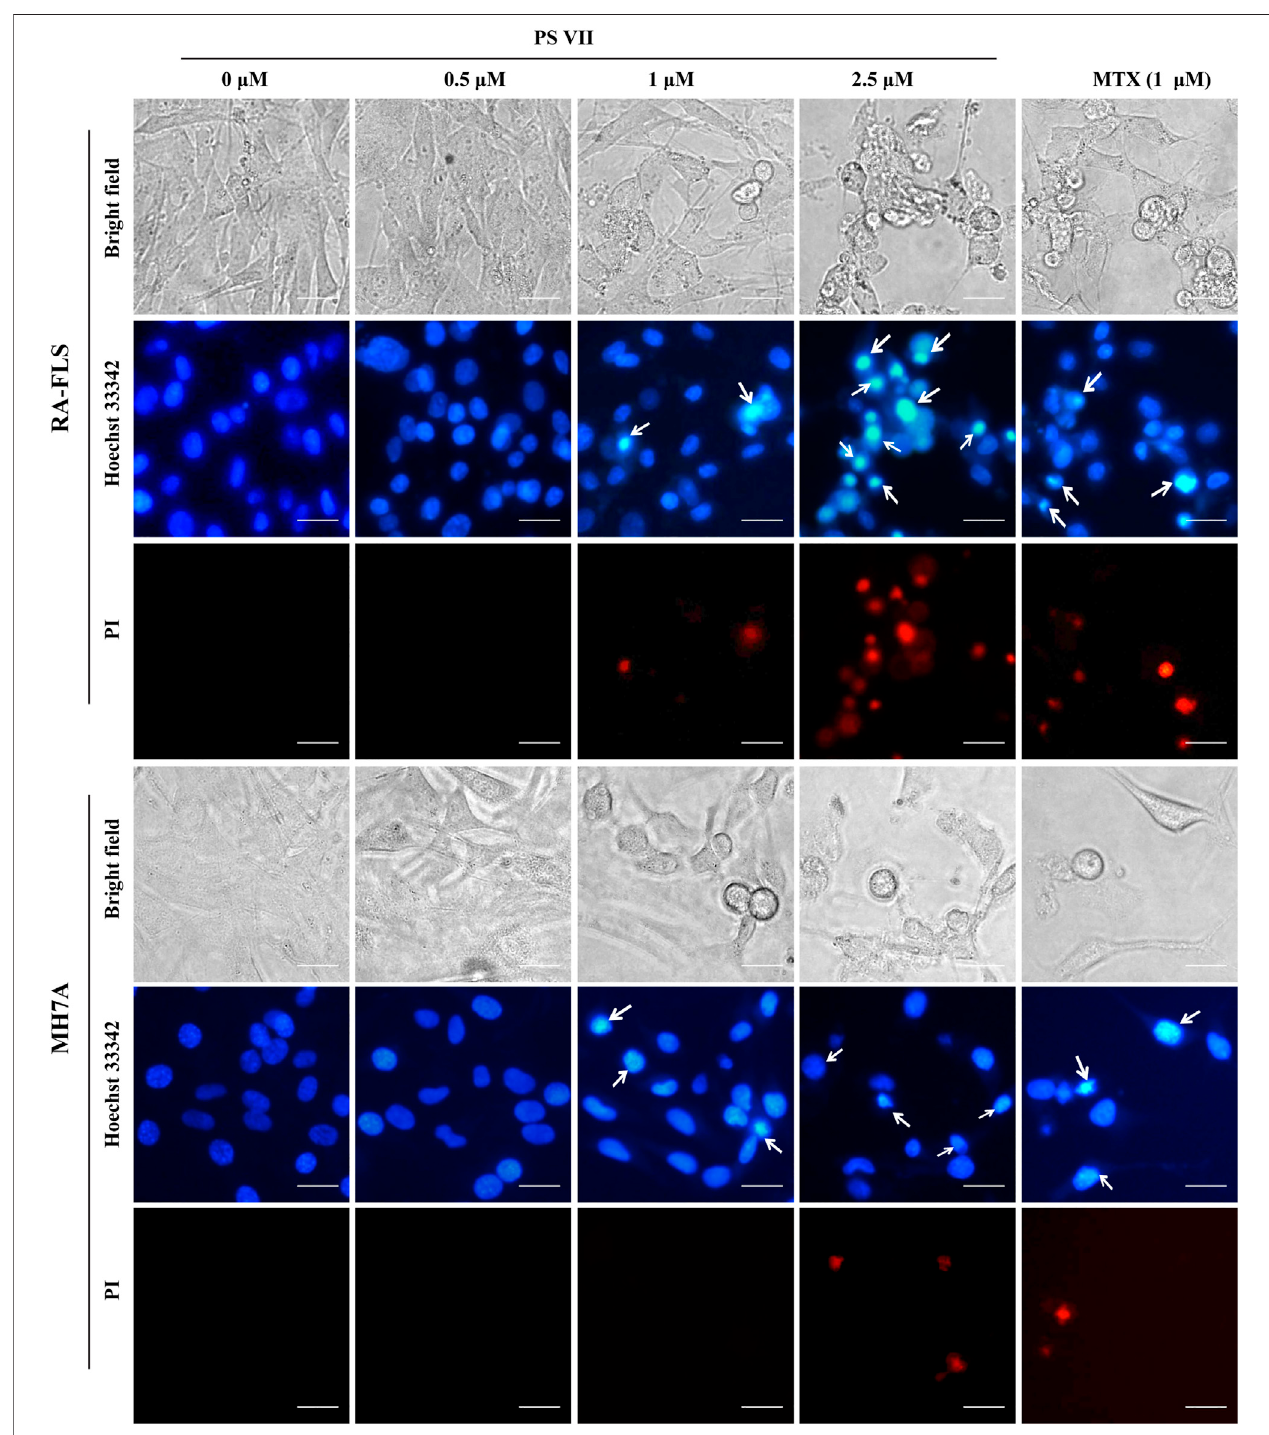
FIGURE 3 | Effects of PS VII on morphological changes in RA-FLS and MH7A cells. Cells were treated with PS VII for 48 h. Nuclear morphology was stained with Hoechst33342/PI cell apoptosis staining assay and was observed under inverted fl uorescence microscope, the white arrow indicates the chromatin concentration and nuclear fragmentation in the cells, microscope magni fi cation × 400, scal bar (cid:2) 20 μ M.